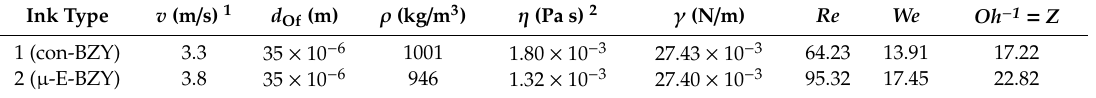
Table 1. Fluid properties of the two different BZY10 inks used in the present study.